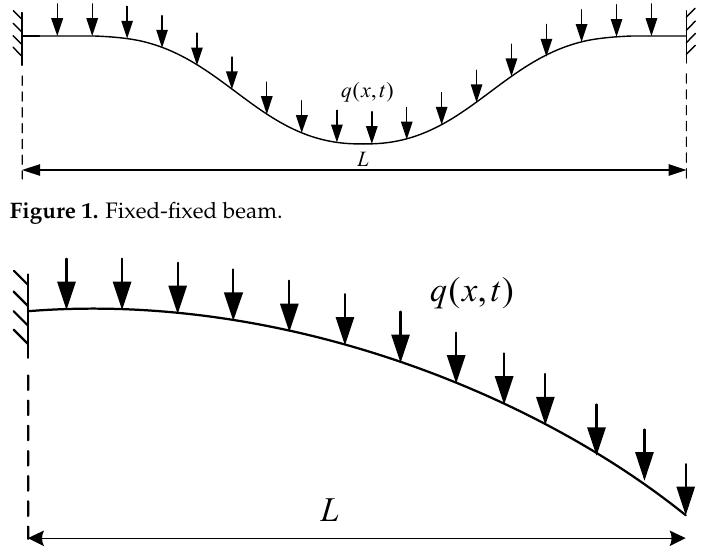
Figure 2. Fixed-free